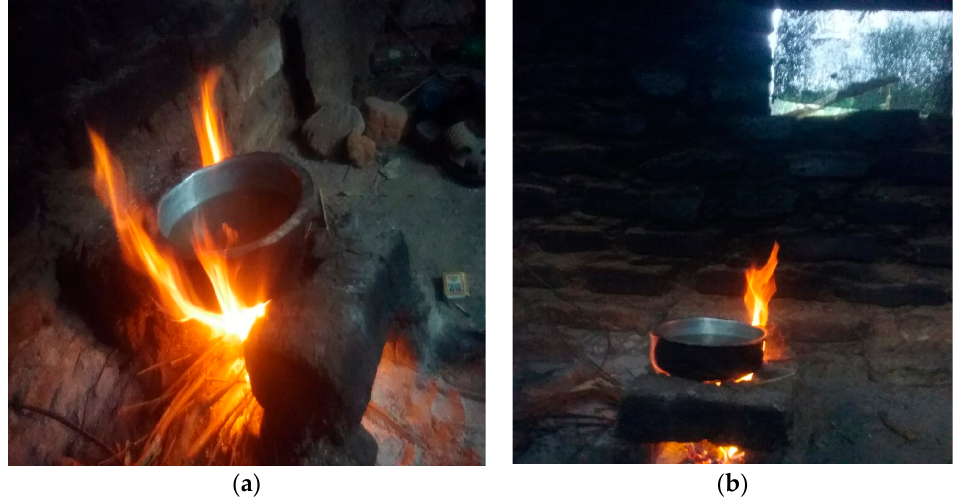
Figure 1. ( a ) Traditional three-stone stove, ( b ) A variation of the three-stone stove.